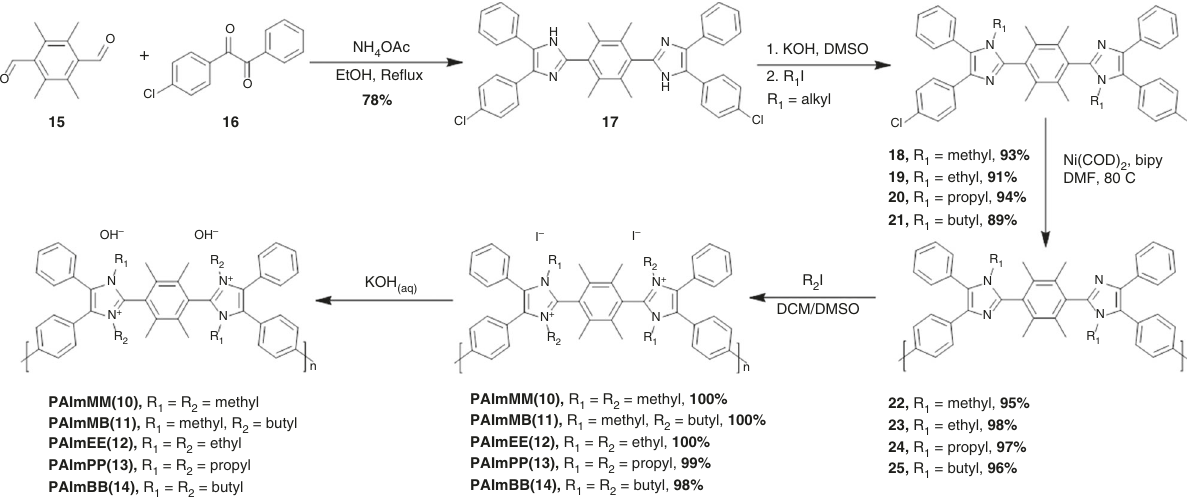
Fig. 4 Synthesis of poly(arylimidazoliums) PAImXY(#). X and Y represent alkyl chains and # represents the analogous model compound illustrated in Fig. 1. Five polymers were synthesized: PAImMM( 10 ), PAImMB( 11 ), PAImEE( 12 ), PAImPP( 13 ), and PAImBB( 14 ), possessing the same architecture as compounds 10 – 14 , where M = methyl, E = ethyl, P = propyl, and B =